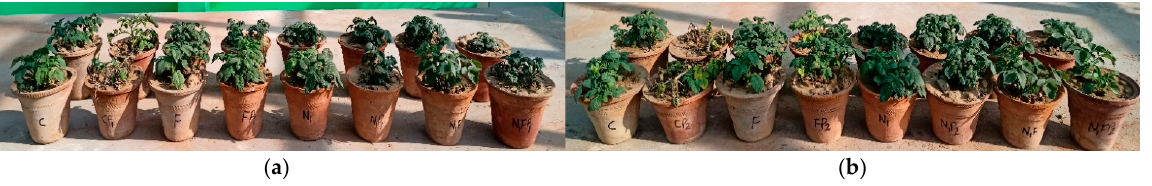
Figure 7. Efficacy of CSGA NCs in pot s against potato pathogens ( a ) Alternaria solani— P1, ( b ) Stemphylium lycopersici— P2; where C—Control, CP1—pathogen P1, F—commercial fungicide, FP1—commercial fungicide + P1, N1—blank NCs, N1P1—pathogen P1 + blank NCs, N1F—mancozeb